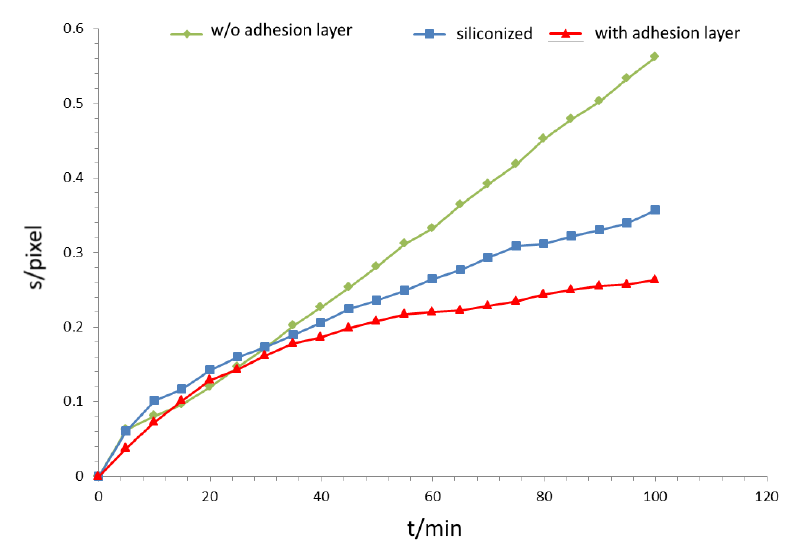
Figure 8. Diagram of interface diffusion (Phase I) for three samples with different surface modifica- tions. The green curve displays the behaviour of a silicone/Cu sample without an adhesive layer. Here, the corrosion-triggered delamination sets in almost immediately converting in a linear course.